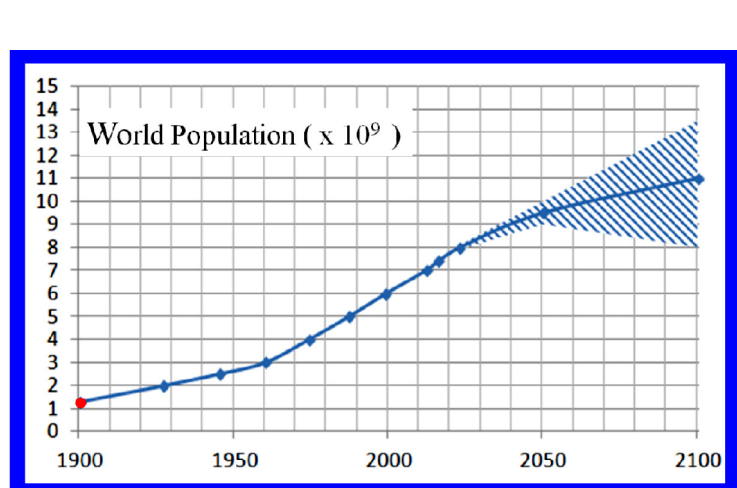
Fig. 1. – The growth of the world population since 1900 and the uncertain future